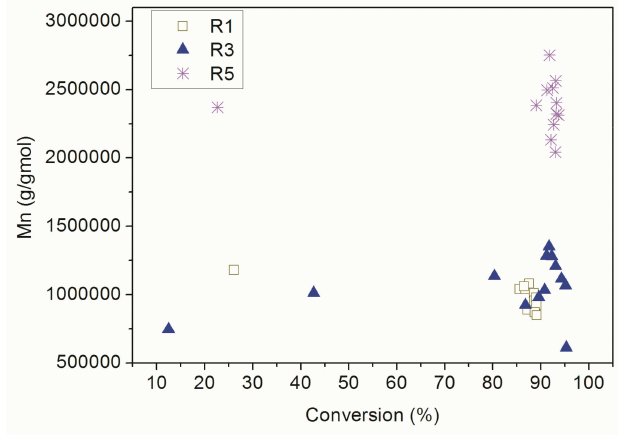
Figure 10. Dynamic evolution of Mn and monomer conversion in the conventional